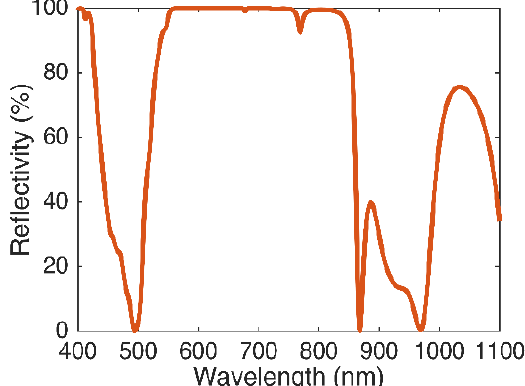
Figure 1. Reflection spectrum curve of multilayer film.